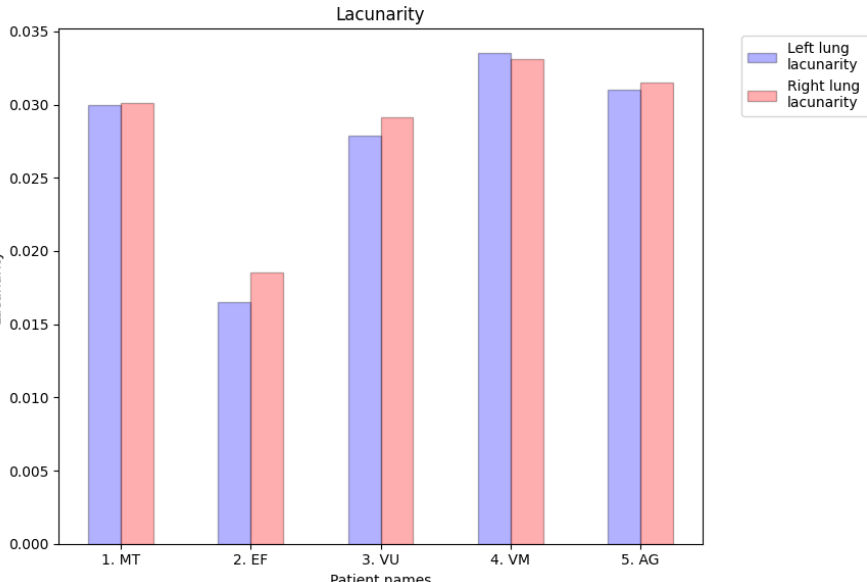
Figure 28. Lacunarity values of CT images of the left lungs and right lungs of affected patients to compare them with those of pulmonary controls.